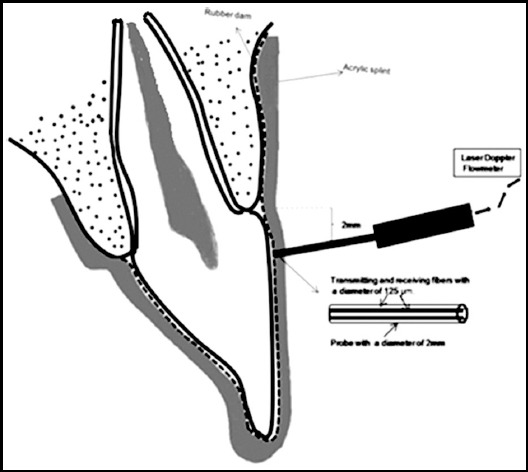
Diagram of the experimental set up.